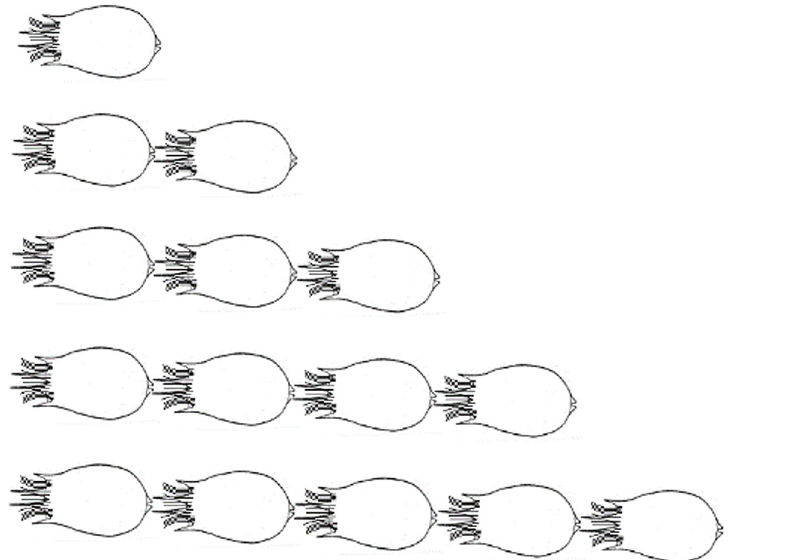
Fig 2. The linear aggregation pattern of B . calyciflorus .